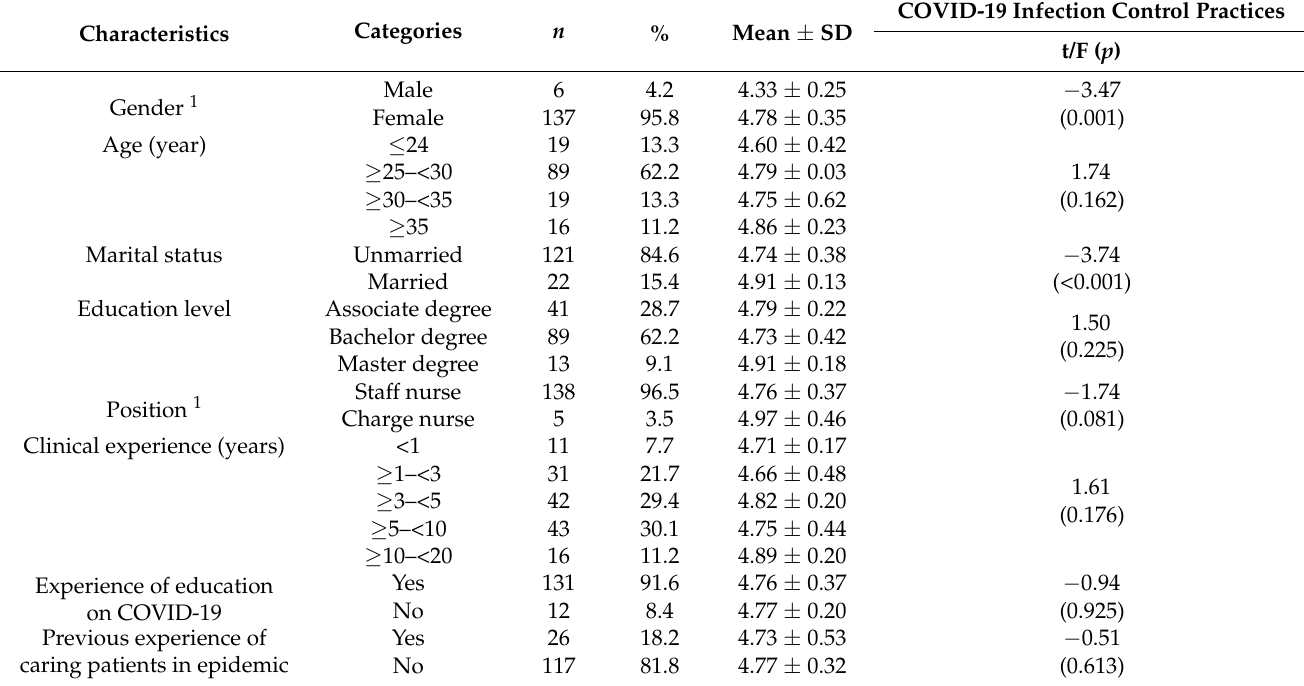
Table 3. Differences in infection control practices according to general characteristics ( n =